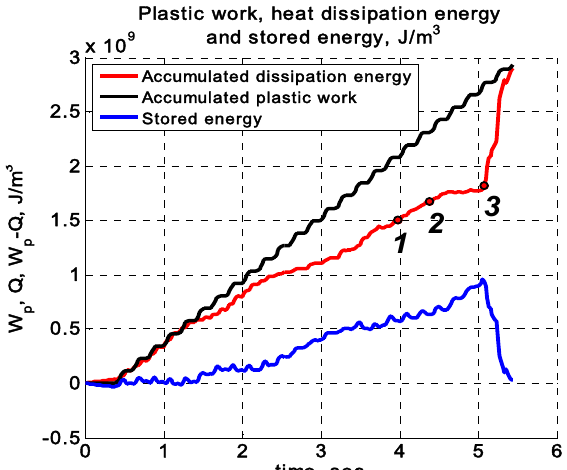
Figure 7: Time dependence of plastic work, heat dissipation energy and stored energy at the point near the crack tip (1, 2, 3 – time points for β -distribution in Fig.